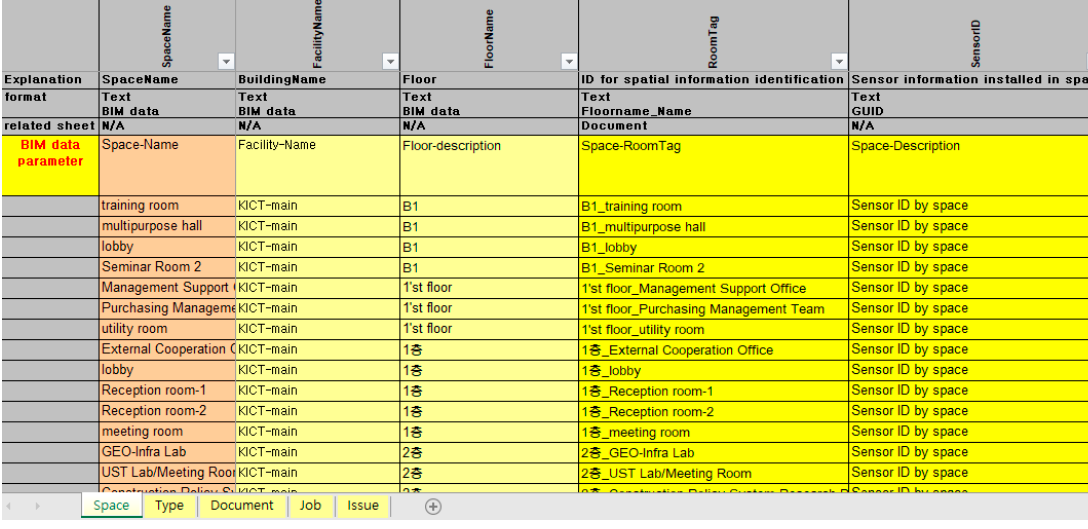
Figure A3 . COBie ‘Space’ datasheet.